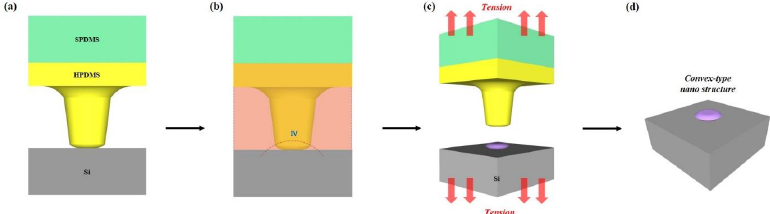
Figure 3. Schematic process flow to fabricate the convex nanostructure from the MPDMS stamp: ( a ) The irreversible bonding step; ( b ) the fully swelling step; ( c ) the breaking step on applied tension; ( d ) the resulting convex nanostructure transferred to the Si